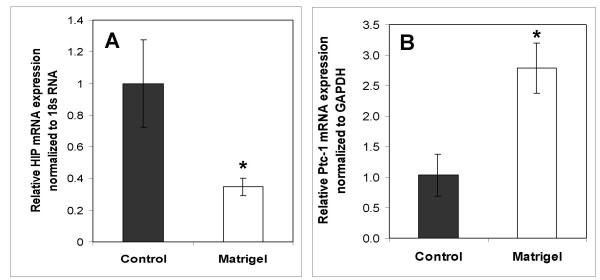
HIP mRNA expression under in vitro angiogenic conditions. A, HIP or B, Ptc-1 expression in HAEC cultured on plastic (control, filled bar) or on Matrigel (open bar). RNA was harvested from cells 16 hours after seeding on plastic or Matrigel, when tubes had fully formed on Matrigel, and assayed for HIP and 18s rRNA, or Ptc-1 and GAPDH mRNA, by Q-RT-PCR. The mean data are plotted as relative HIP mRNA normalized to 18s rRNA, or Ptc-1 mRNA normalized to GAPDH mRNA, and are the average of three (HIP) or two (Ptc-1) independent experiments performed in triplicate. Error bars show standard deviation. Differences in normalized HIP or Ptc-1 expression were significant for control vs. Matrigel (*p < 0.05, two-tailed Student's t-test).